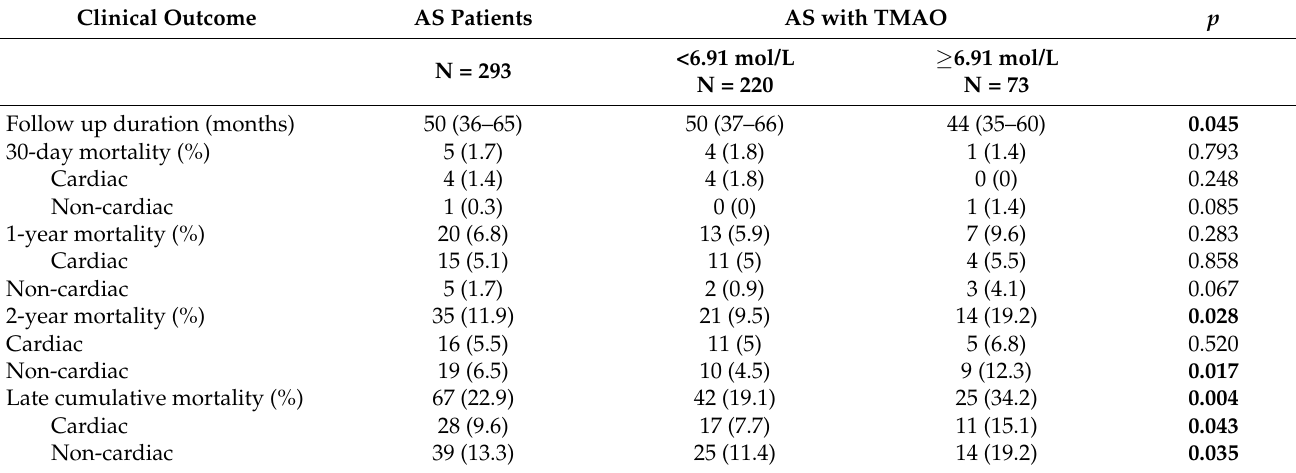
Figure 2. Late cumulative and 2-year event rate of mortality according to elevated TMAO. Kaplan– Meier analysis of late cumulative all-cause mortality ( A ), cardiac mortality ( B ), and non-cardiac mortality ( C ) stratified by TMAO levels in AS patient after TAVR. TAVR = transcatheter aortic valve replacement. TMAO = Trimethylamine N-oxide.